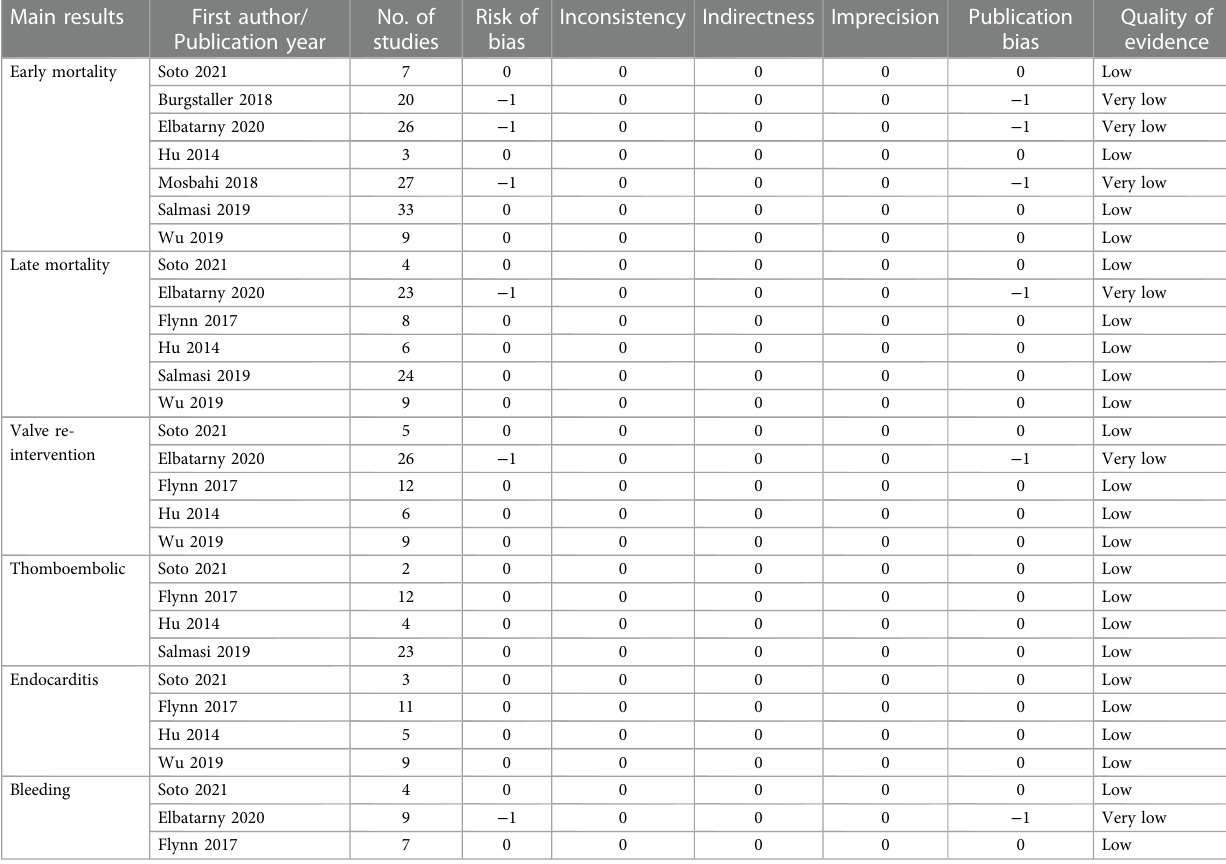
TABLE 4 Main results assessed by the grading of recommendations, assessment, development and evaluations. Main